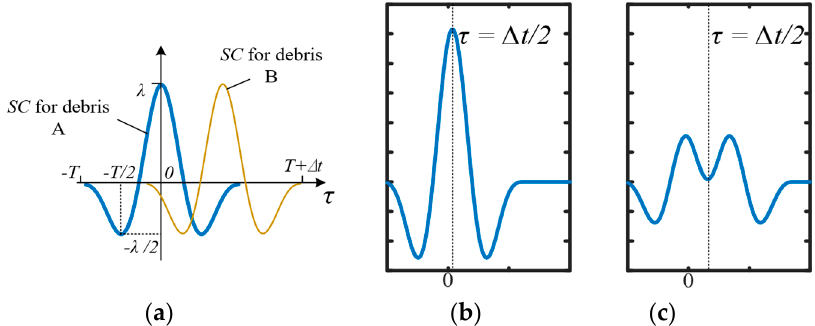
Figure 6. Performance of the CC for aliasing signal when ∆𝑡 moves; ( a ) result of CC for Debris A and B’s signal before summing; ( b ) 𝑐(𝜏) ’s waveform, Situation 1; ( c ) 𝑐(𝜏) ’s waveform, Situation 2.